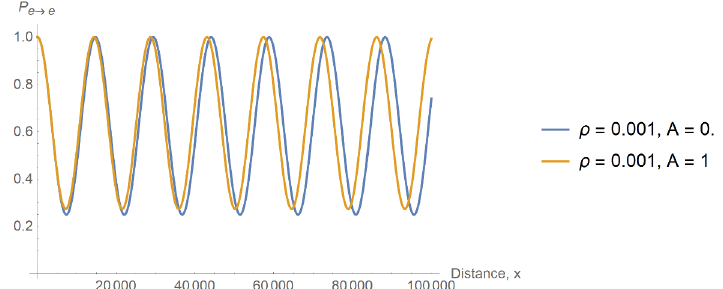
Figure 3. Plot of electron neutrino survival probability, P e → e , as a function of distance, x , for various nonlinearity strengths (di ff erent values of A ), for nonzero background matter number density. A larger A value indicates a stronger